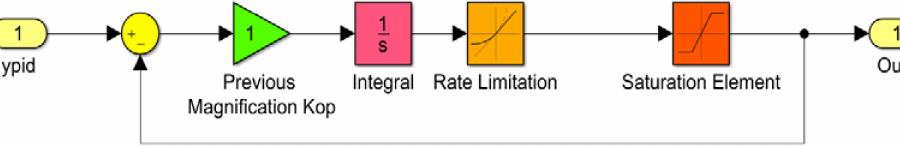
Figure 3. Block diagram of the hydraulic cylinder sector.